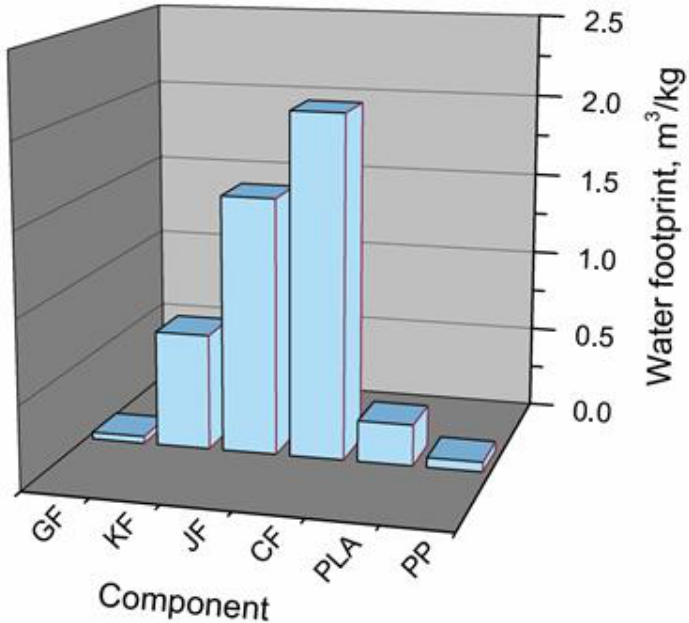
Figure 12. Comparison of water footprint values for all applied raw materials.